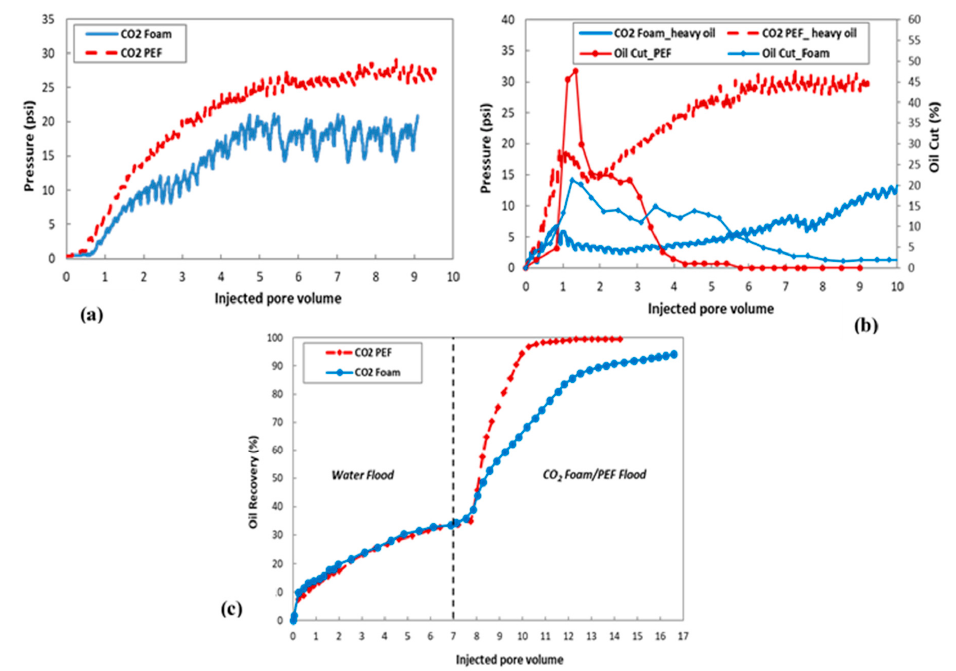
Figure 5. CO 2 PEF showed higher injection pressure and higher/faster oil recovery compared to CO 2 foam injection. ( a ) Pressure profile in the water-saturated porous medium, ( b ) pressure profile and oil cut in oil-saturated medium (after waterflood), and ( c ) oil recovery profile of CO 2 foam and CO 2 PEF. Oil cut is defined as the percentage of oil produced relative to total fluid produced at a given time. The vertical line shows the start of foam / PEF